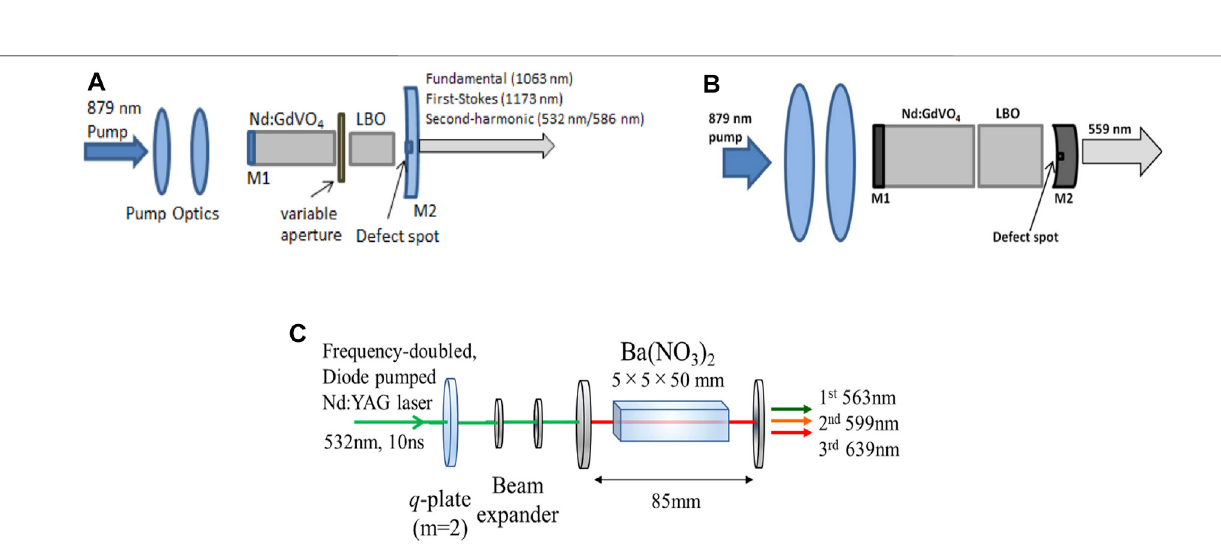
Figure 6D . The LG 0,n mode petal-like lasers with order of n tuning from 3 to 11 had been obtained. [124].